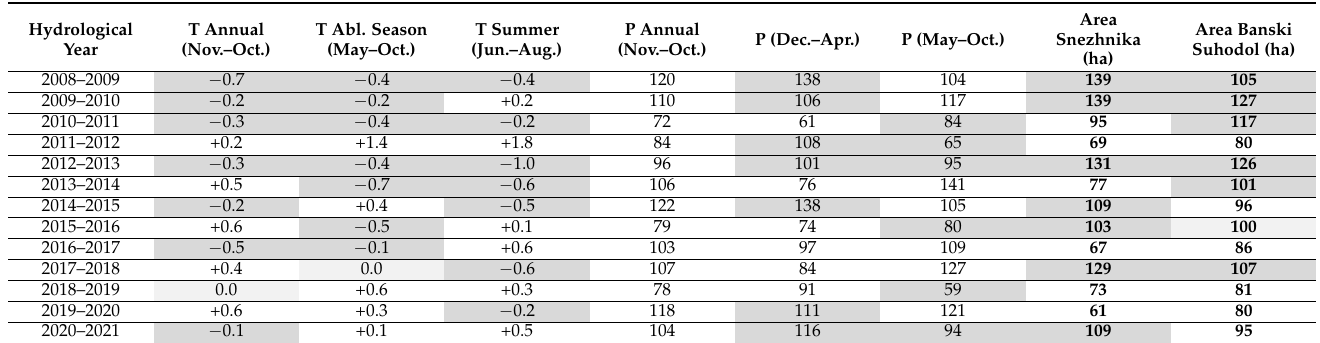
Table 2. Climatic anomalies (subtraction for temperature and percentage for precipitation and glacier area) referred to the 2008/09–2020/21 average for Musala peak meteorological station (data from [32]), summarized for glacieret hydrological